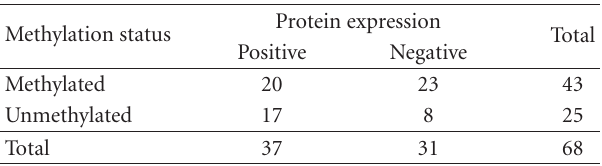
Table 5: Correlation of methylation status of RB gene with its protein